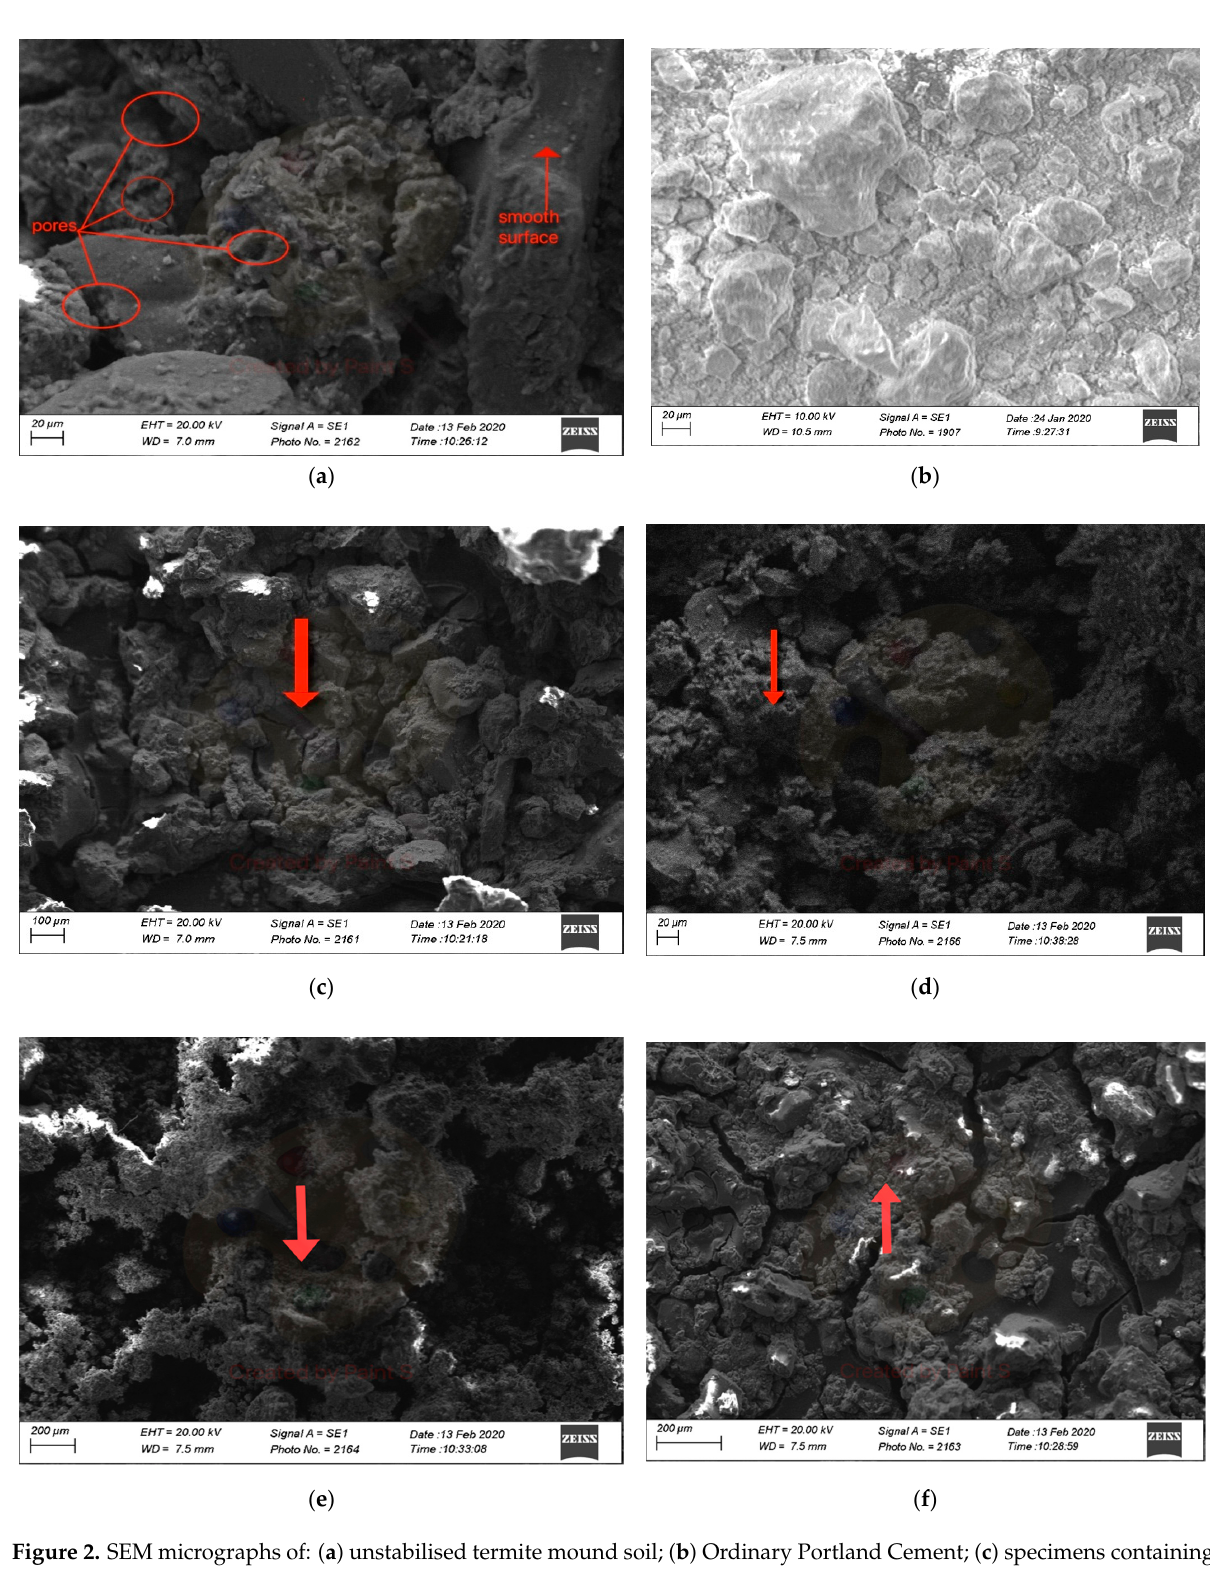
Figure 2. SEM micrographs of: ( a ) unstabilised termite mound soil; ( b ) Ordinary Portland Cement; ( c ) specimens containing 5 wt% of stabilisation; ( d ) specimens containing 10 wt% of stabilisation; ( e ) specimens containing 15 wt% of stabilisation; f ) specimens containing 20 wt% of stabilisation.